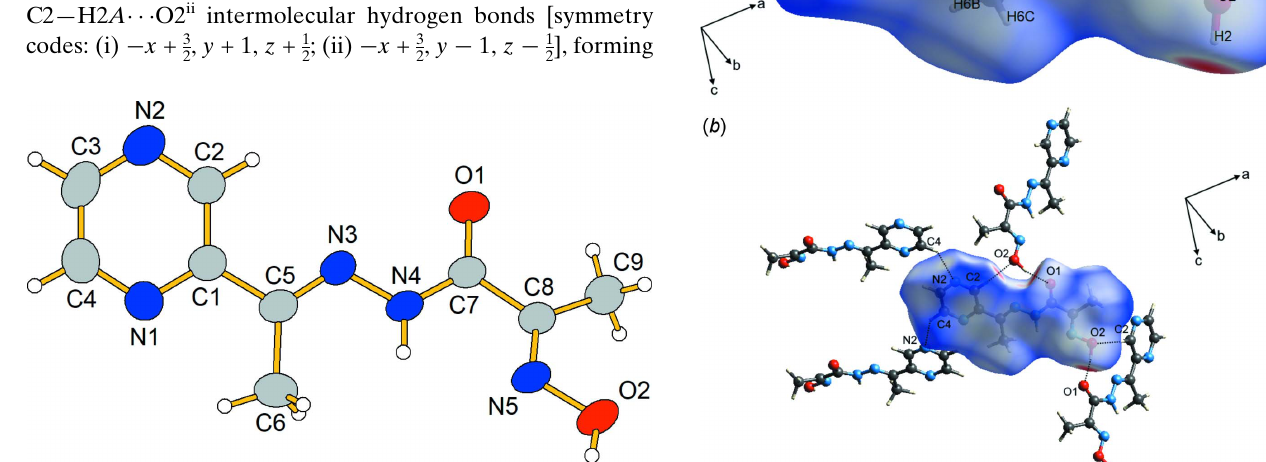
Figure 1 The molecular structure of the title compound 1 with displacement ellipsoids shown at the 50% probability